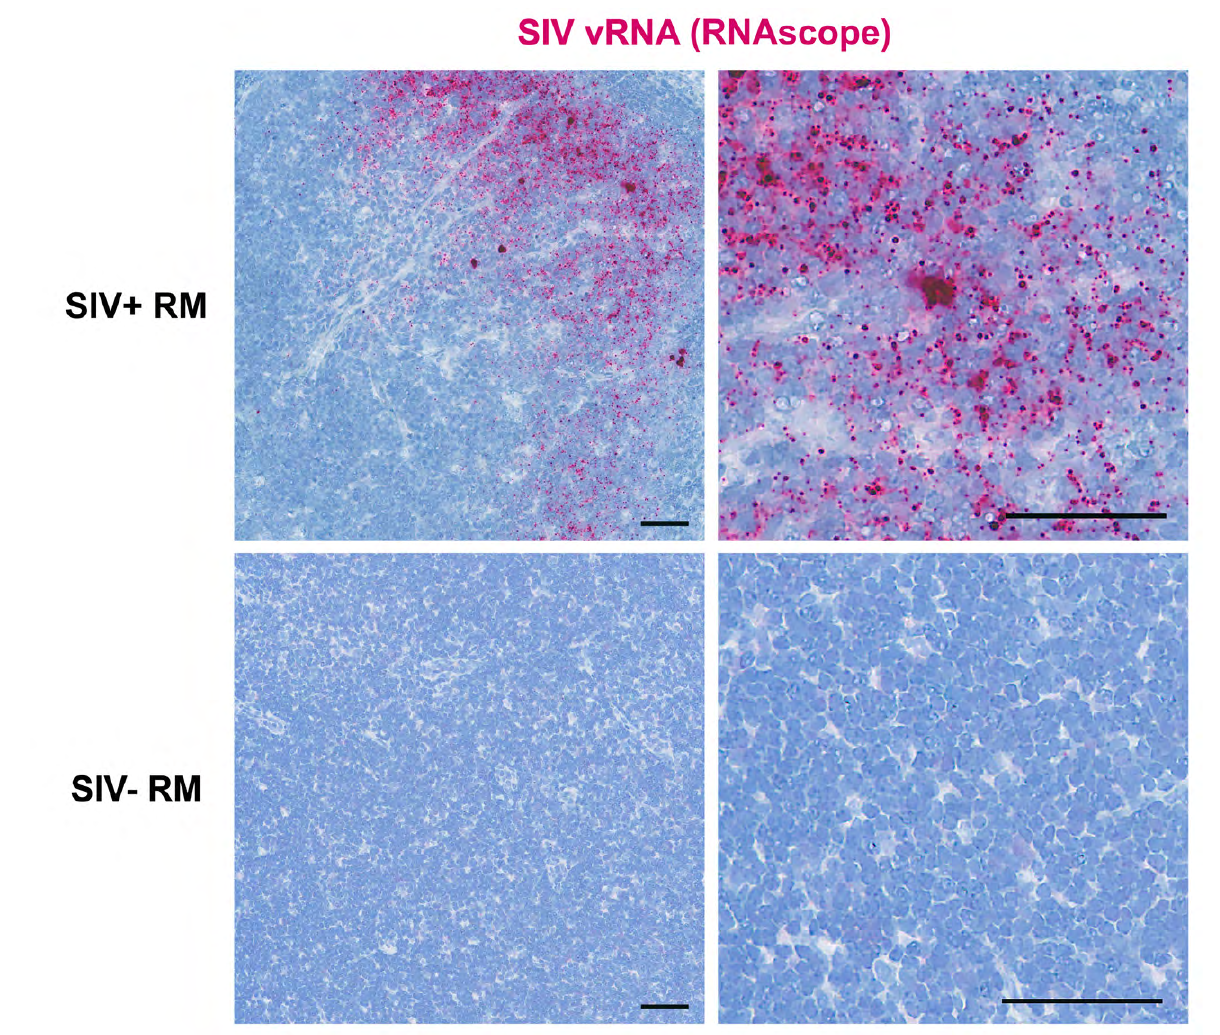
Supplemental Figure 2. Specificity of RNAscope for the detection of vRNA+ cells and viral particles. Representative low and high magnification RNAscope in situ hybridization (ISH) images from a chronical- ly SIV-infected rhesus macaque (RM) (top panel) and a SIV-negative RM (bottom panel) demonstrating the robust detection of SIV vRNA only SIV-infected, but not in SIV-negative lymphoid tissues. Scale bars = 50